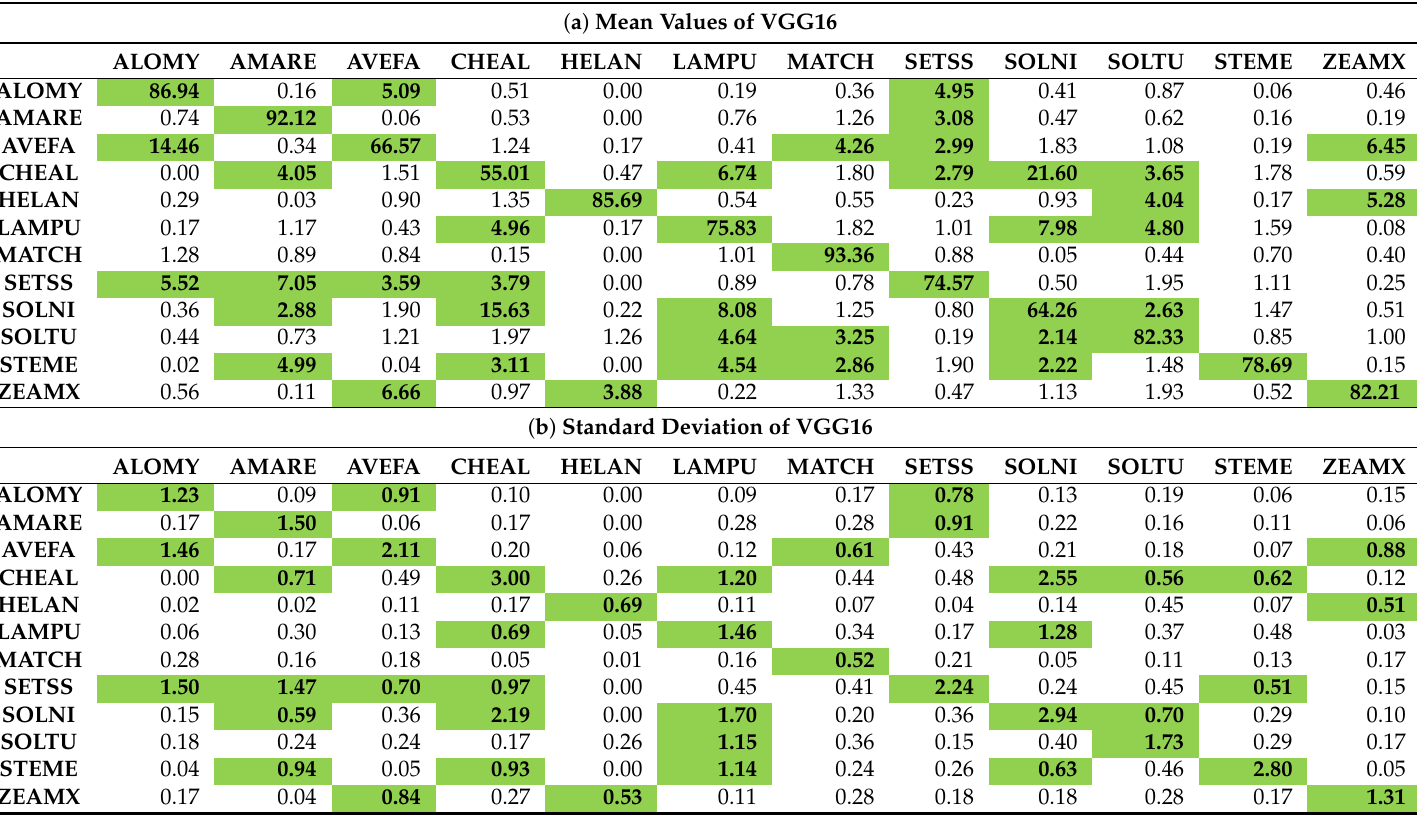
Table 3. Confusion matrix of the mean crop and weed identification for the VGG16 Convolutional Neural Network. The prediction reached between 81.0 and 82.7 % top-1 accuracy on the test dataset. The values are the percentage of identified labels for each plant species (Each row sums to 100%). ( a ) Mean values for the ten training runs. Cell values above 2% are highlighted. ( b ) The standard deviation for the ten training runs. Standard deviation values above 0.5% are